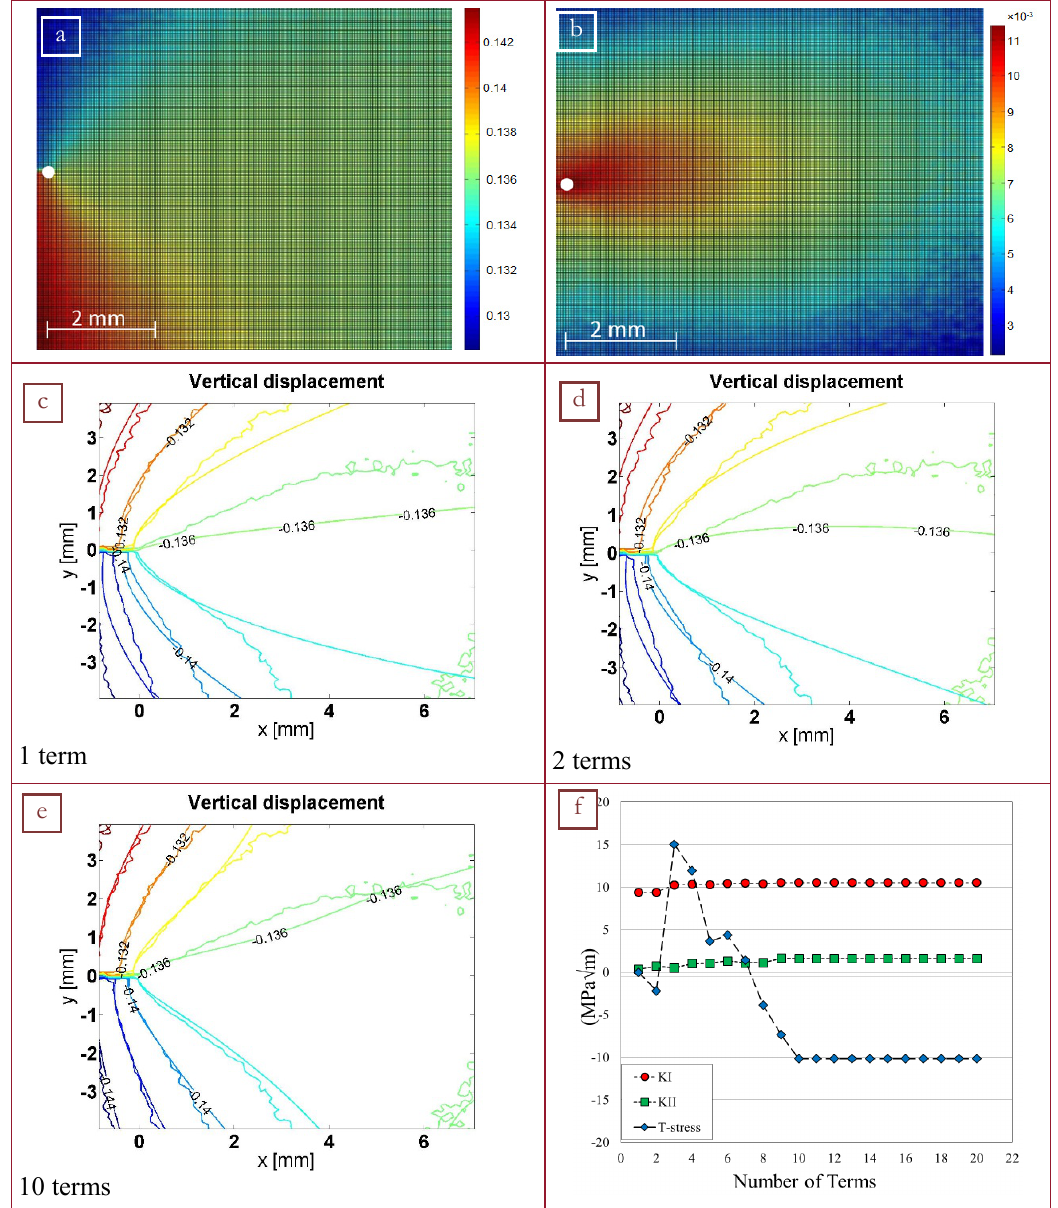
Figure 4. Analysed displacement field, a) vertical displacement, b) horizontal displacement. Fitting of displacement data to Williams’ solution with one (c), two (d) and 10 terms (e) and stability of calculated SIF and T-stress for the first 20 terms of Williams’ series